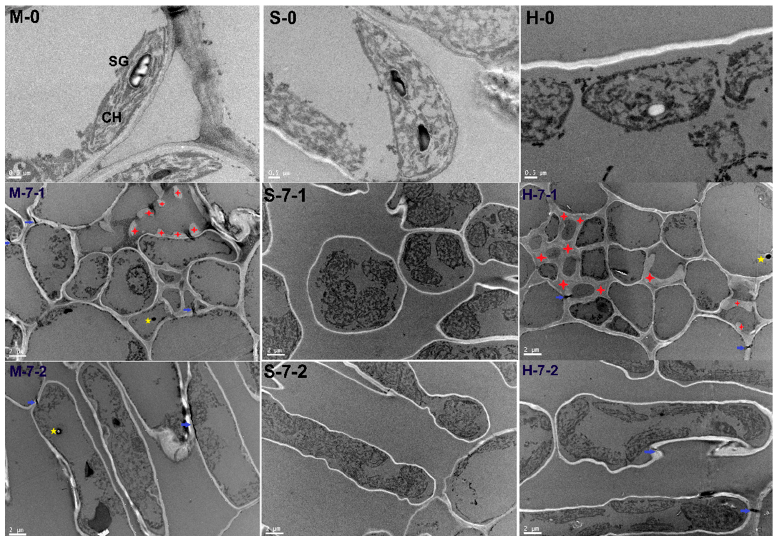
Figure 11. Comparison of cell ultra-structure of leaves of different peach rootstocks exposed to 7 d of waterlogging stress under TEM (SG: starch granule; CH; chloroplast; red and yellow asterisk: mycorrhizal fungi infection; blue arrow: mycelium; bar = 0.5 μ m (M-0, S-0, H-0); bar = 2 μ m (M-7-1 and M-7-2, S-7-1 and S-7-2, H-7-1 and H-7-2)). Abbreviations: M: Prunus persica, ‘Maotao’; S: Prunus davidiana, ‘Shantao’; H: ‘Hossu’. Leaf samples were collected under un-stressed condition (M-0, S-0, H-0) and on the 7th day (M-7-1 and M-7-2, S-7-1 and S-7-2, H-7-1 and H-7-2) of WT. Under non-stressed condition, fine root cells of all three tested rootstocks displayed mycorrhizal fungus infection (Figure 12 M-0, S-0, H-0, red asterisk) and intercellular hy- phal junction (Figure 12 M-0, S-0, H-0, blue arrow). The rate of intracellular mycorrhizal infection (Figure 12 M-7, S-7, H-7, red asterisk) and the hyphal connection between adja- cent cells (Figure 12 M-7, S-7, H-7, blue arrow) in the fine roots of H rose the greatest until the 7 th day of waterlogging treatment, whereas that of S altered the least.